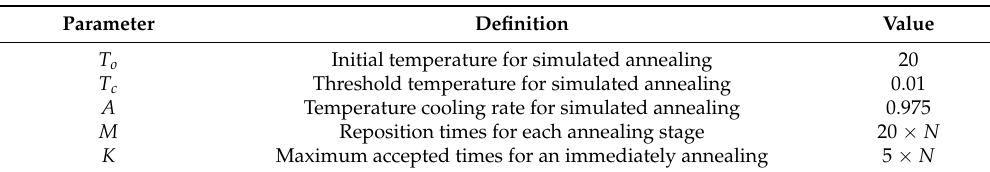
Table 2. Parameter values for the labeling